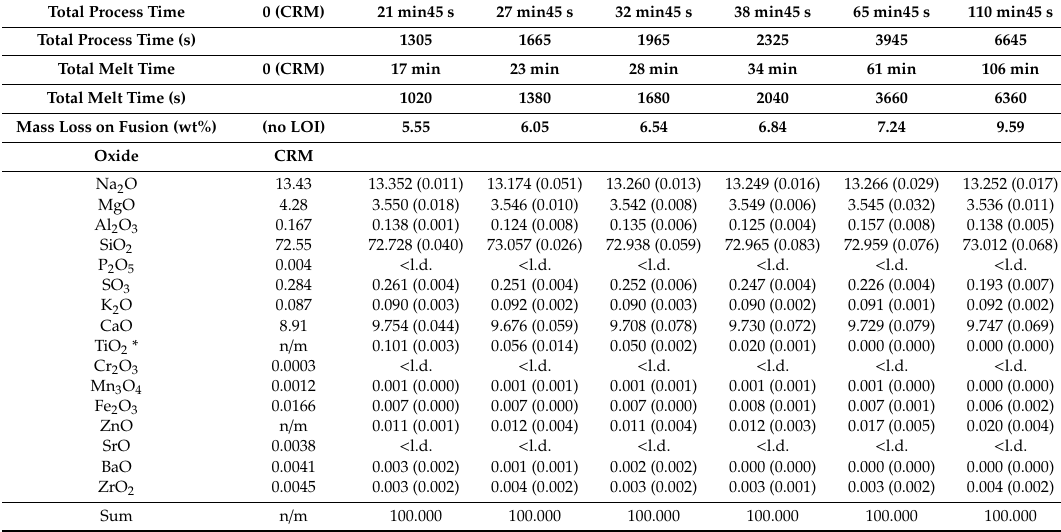
Table A4. XRF data for Low-Iron Float Glass (CRM-525, [44]) as a function of total process and melt times. Data are averages of 4 measurements. Calculated standard deviations shown in brackets; < l.d. = below limit of detection; n / m = not measured; * analysed TiO from I L β 1,2,3